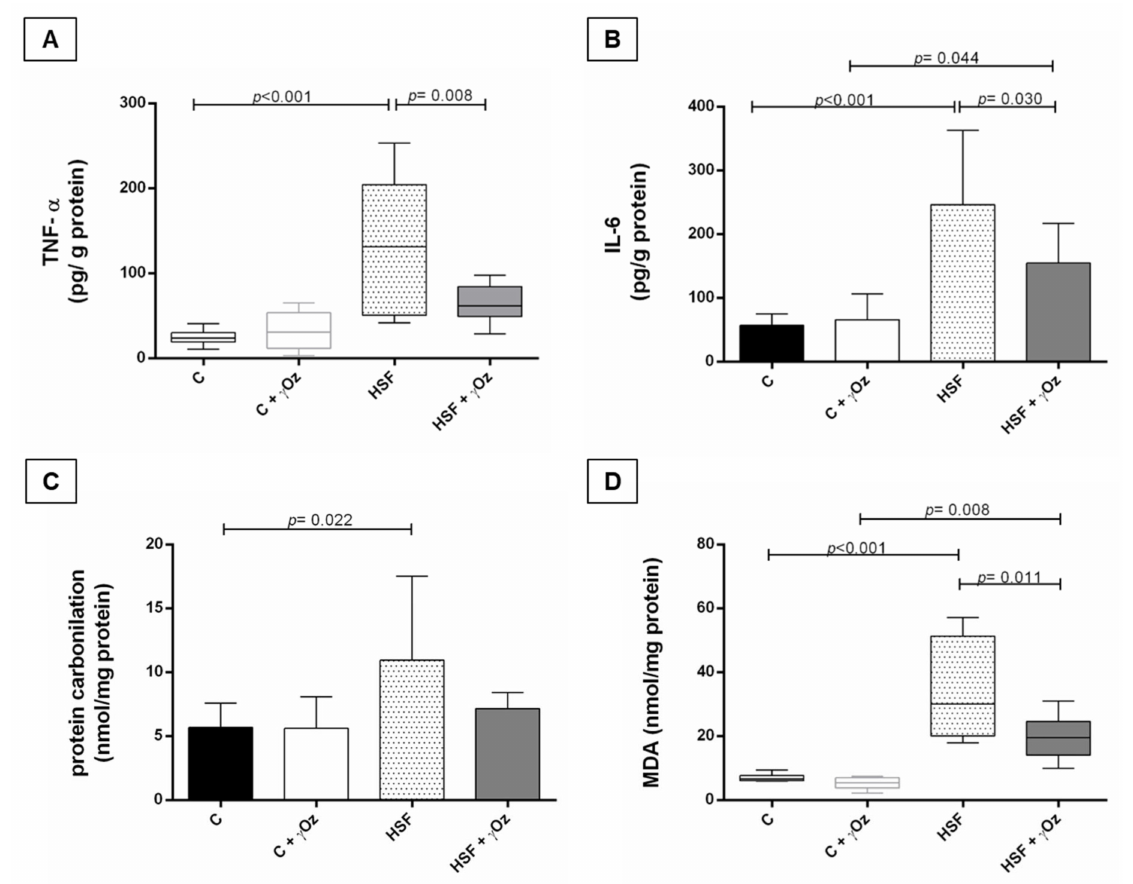
Figure 4. Oxidative stress and inflammatory parameters. ( A ) Tumoral necrosis factor alpha (TNF- α , pg/g protein); ( B ) Interleukin-6 (IL-6, pg/g protein); ( C ) Protein carbonylation (nmol/mg protein); ( D ) Malondialdehyde (MDA, nmol/mg protein). Comparison by two-way ANOVA followed by Tukey test. p < 0.05 as